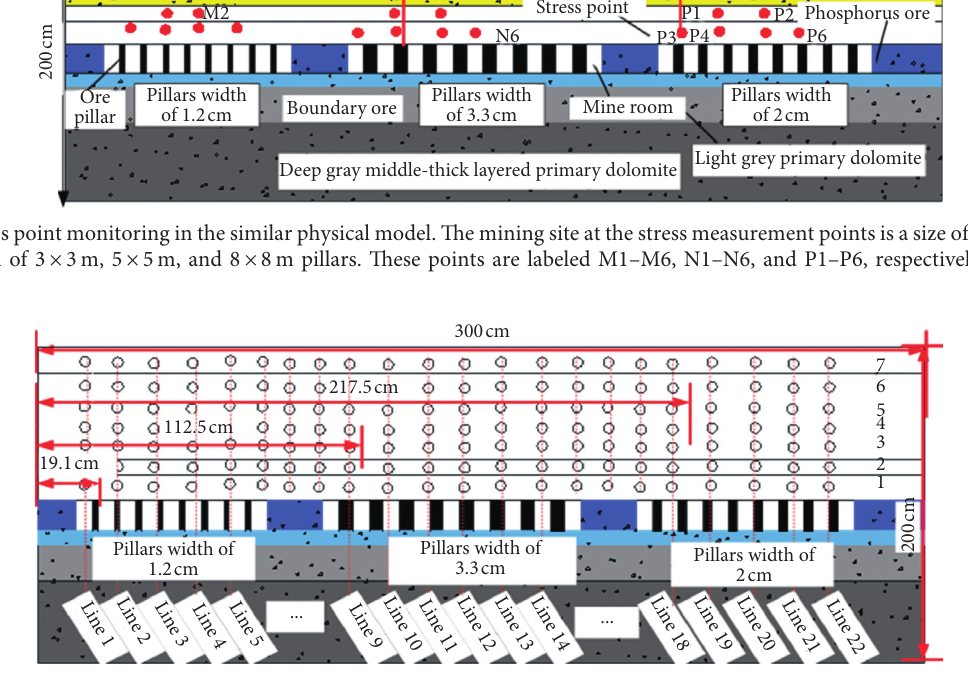
Figure 4: Displacement point monitoring. The measurement lines are marked as Line 1 to Line 22 in order from left to right. Each measurement line has seven measurement points. The measurement points are marked as LB-1, LB-2, LB-3, LB-4, LB-5, LB-6, and LB-7, with B denoting the line number, according to the distance from the stope roof (6.25 cm, 10.4cm, 14.5cm, 22.9cm, 31.2 cm, 43.7cm, and 56.2cm, respectively).